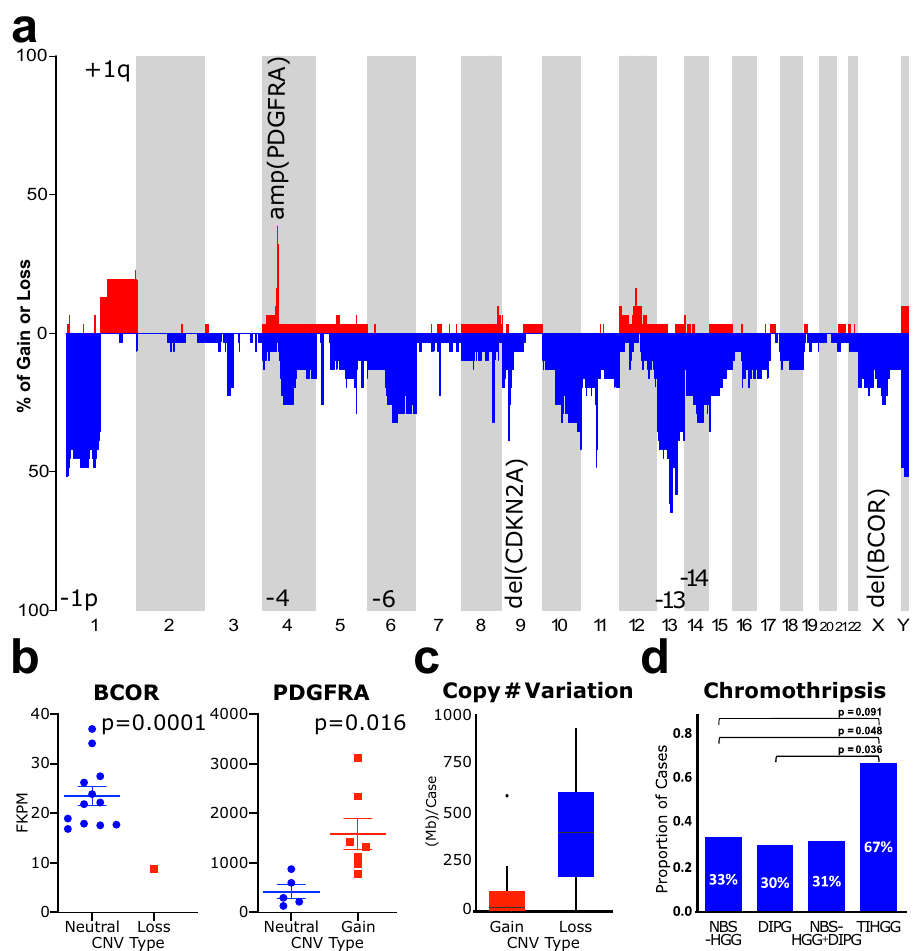
Fig. 3 Frequent copy-number alterations in RIG. a Copy-number frequency plot showing the percentage of samples with gain or loss by chromosome. Locations of speci fi c copy-number alterations discussed in the text are labeled. b Expression-based con fi rmation of high-frequency copy-number alterations in PDGFRA ( P = 0.016) and BCOR ( P = 0.0001); mean and SEM are shown. c Frequency of copy-number gain and loss across all RIG; boxes show median and fi rst and third quartiles, with whiskers representing the range limited to 1.5× the interquartile range from the box edge. d Frequency of chromothripsis in RIG vs. primary NBS-HGG, primary DIPG, and combined NBS-HGG and DIPG (one-sided Fisher ’ s exact test). RIG radiation-induced high- grade glioma, NBS-HGG nonbrainstem high-grade glioma, DIPG diffuse intrinsic pontine glioma, pHGG pediatric high-grade glioma, SEM standard error of the mean. In panel b , the P value for BCOR is computed using Student ’ s single-sample, two-sided t test; the P value for PDGFRA is computed using Student ’ s two-sample, two-sided t